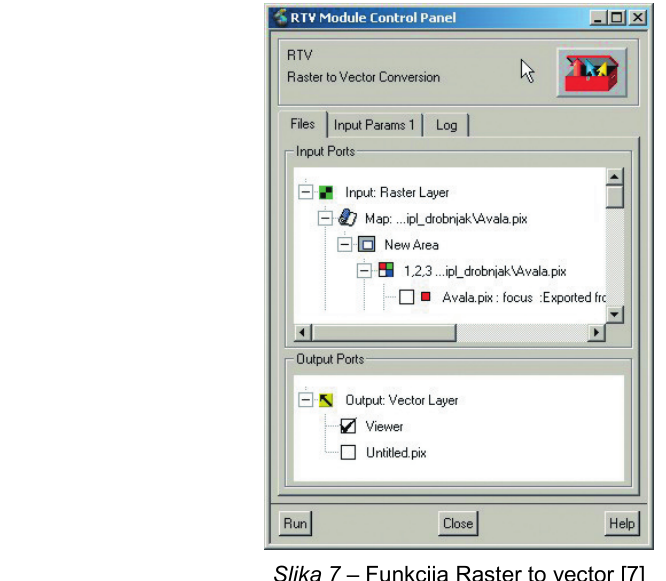
Slika 7 – Funkcija Raster to vector